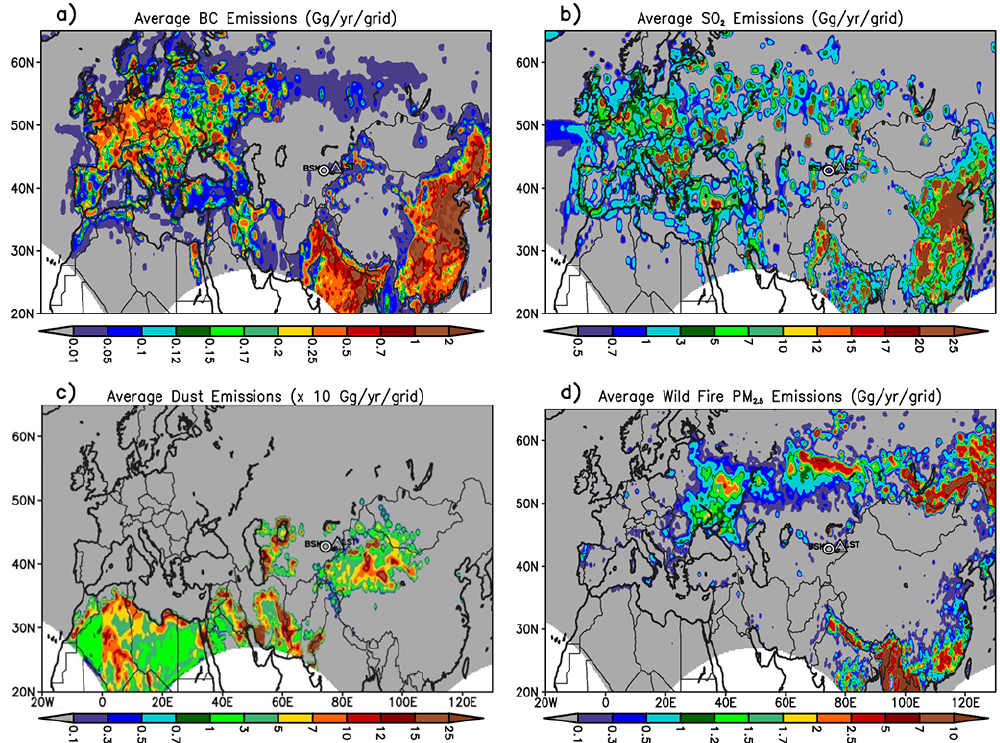
Figure 2. Spatial distribution of (a) BC, (b) SO 2 , (c) natural dust, and (d) biomass burning PM 2 . 5 emissions averaged over the simulation period in Ggyr − 1 grid − 1